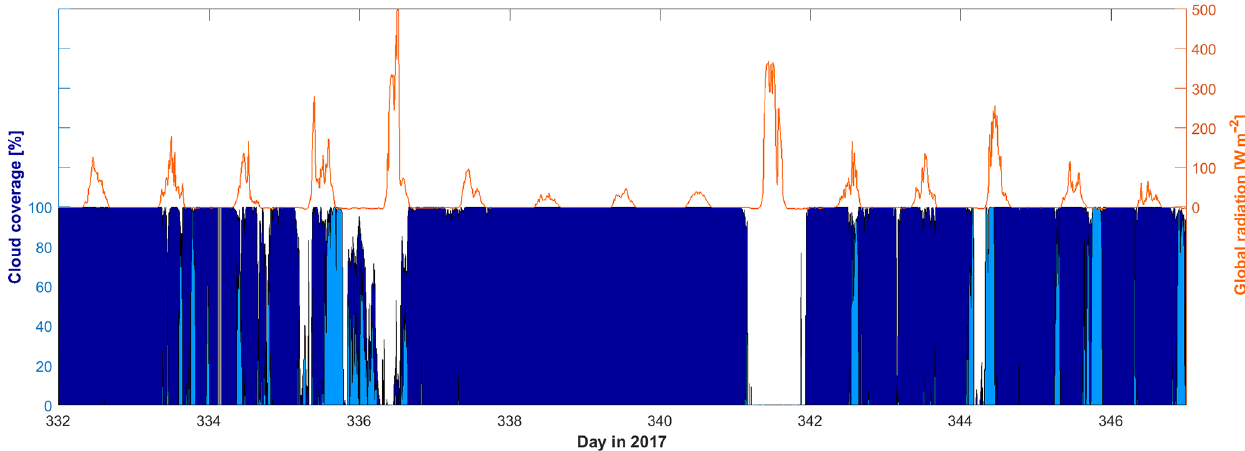
Figure 11. Total cloud coverage (dark blue) and portion of medium- plus high-level clouds (light blue) in comparison with the global radiation as measured by the